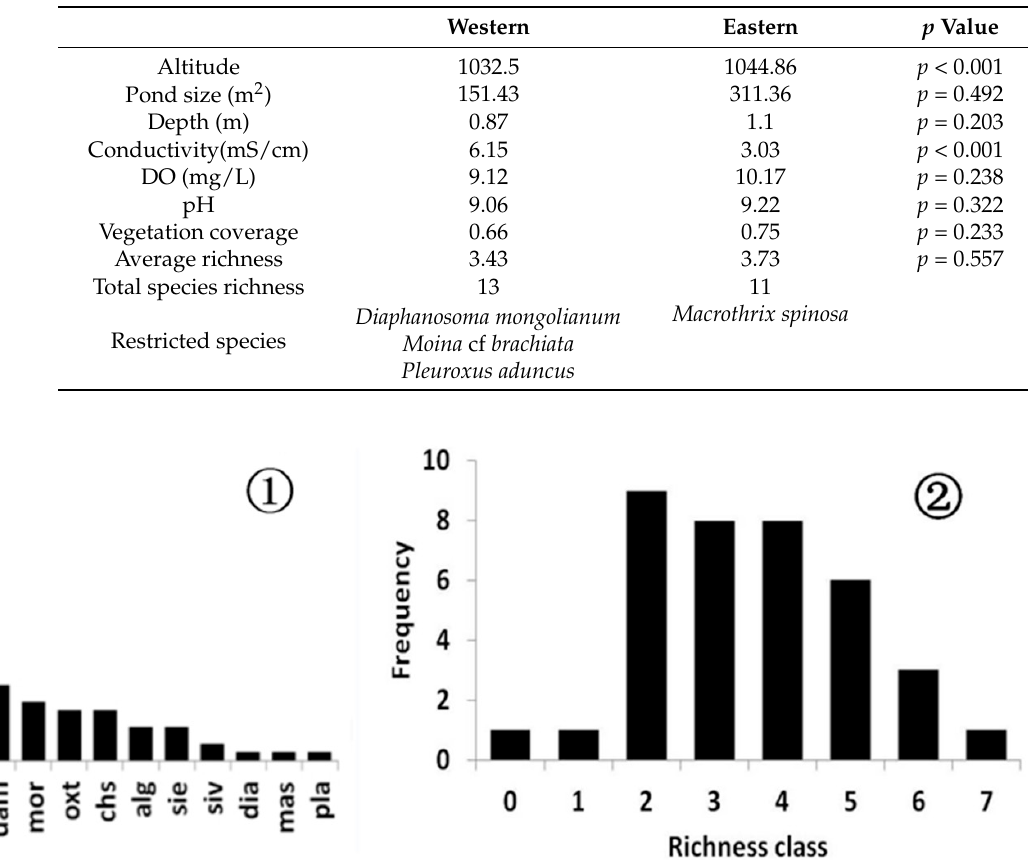
Table 1. Average values of environmental variables and endemic species in western and eastern ponds. t-tests were performed for the two pond groups.